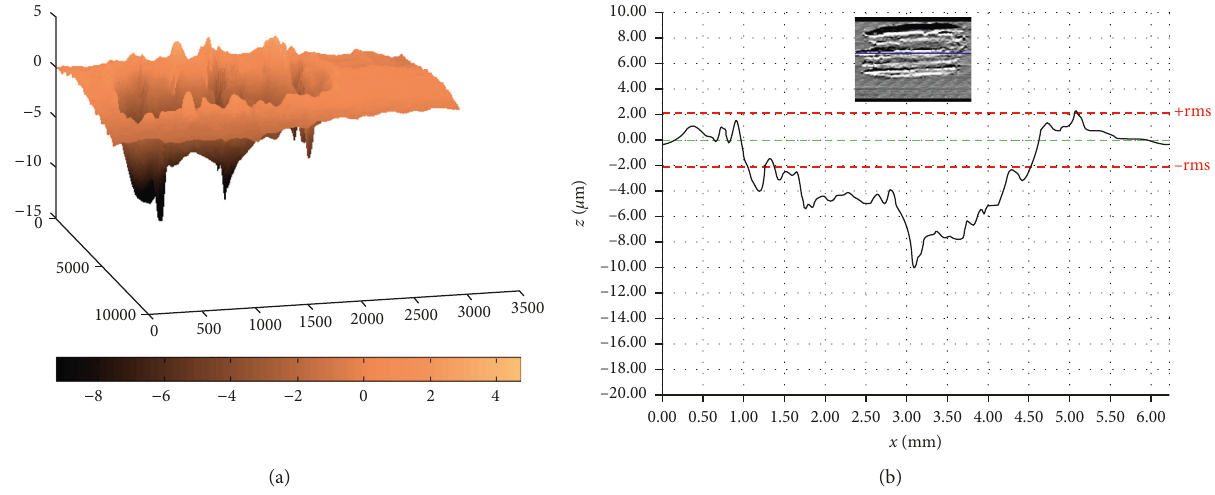
Figure 12: Three-dimensional image of the disk track of steel 3 tested at 40 ° C (a). The maximum profile depth (10 µ m) (b).